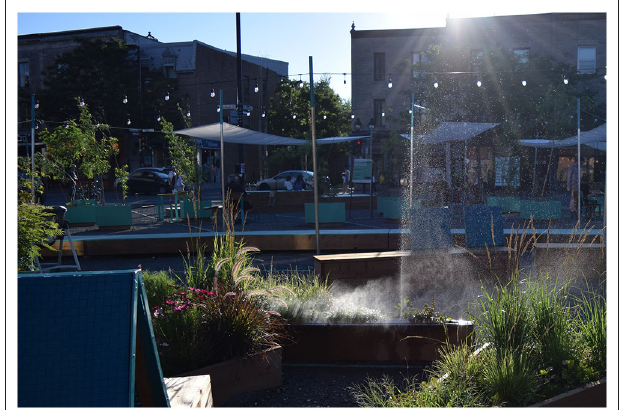
FIGURE 2 | Picture of the mister from Design 2. The effect and jet of the misters for each design was similar. Copyright to Cynthia Tarlao for this